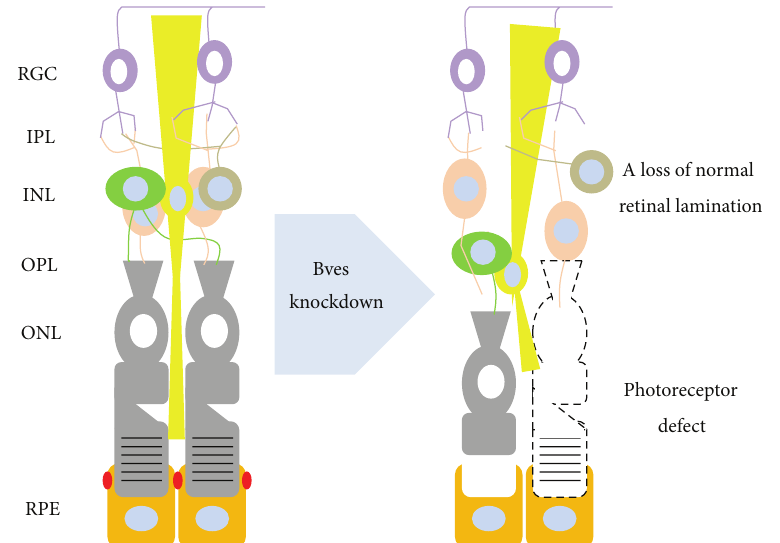
Figure 5: Illustration of Bves effect on zebrafish retinogenesis. RGC, retinal ganglion cells; IPL, inner plexiform layer; INL, inner nuclear layer; OPL, outer plexiform layer; ONL, outer nuclear layer; RPE, retinal pigment epithelium. Red spot indicates tight